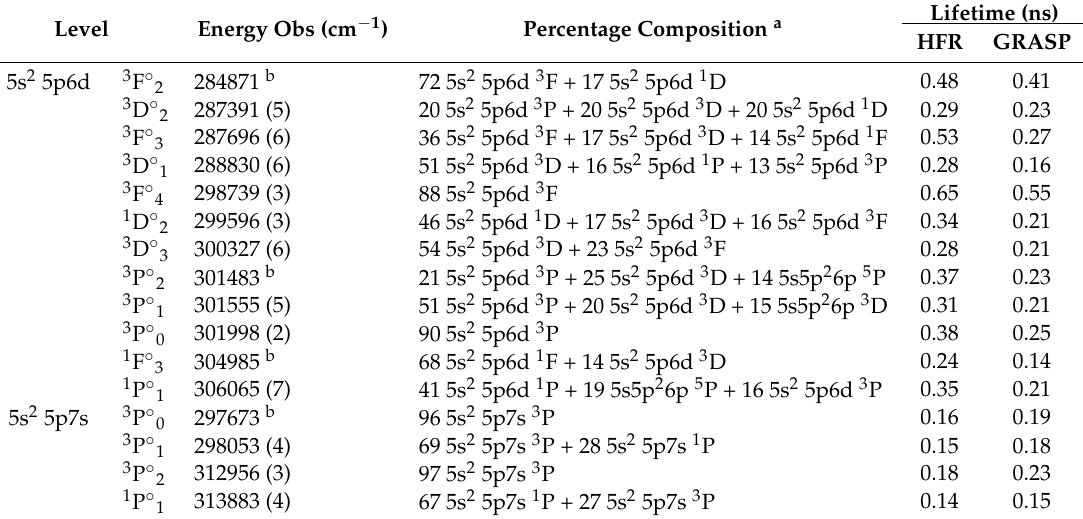
Table 1. Experimental and calculated energy levels established for the 5s 2 5p6d and 5s 2 5p7s configurations of Xe V. Calculated radiative lifetimes are also given. Reproduced with permission from [40]. (© IOP Publishing. All rights